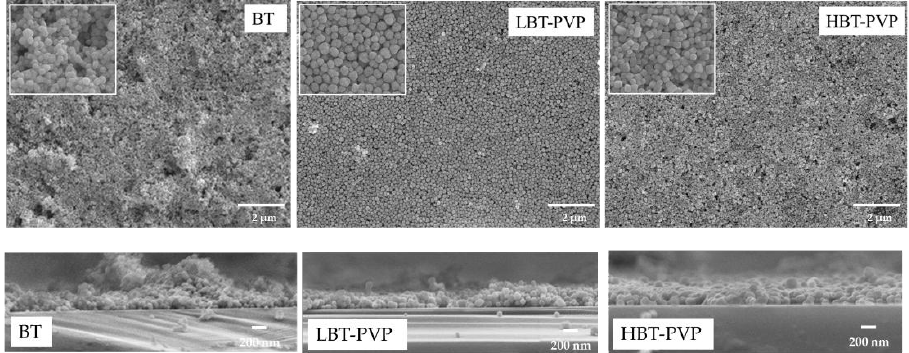
Figure 7. SEM images of film surface ( top ) and cross section ( down ). The film were prepared by 5 wt % BT, LBT-PVP, and HBT-PVP in EtOH coated on Si substrate. The insets are high-magnification SEM images of the films surface.